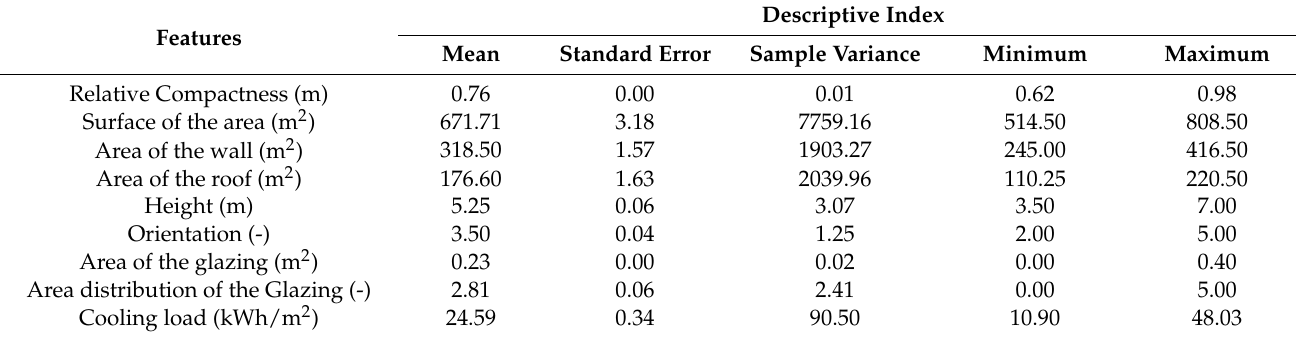
Table 1. Statistical indices to describe the input/target